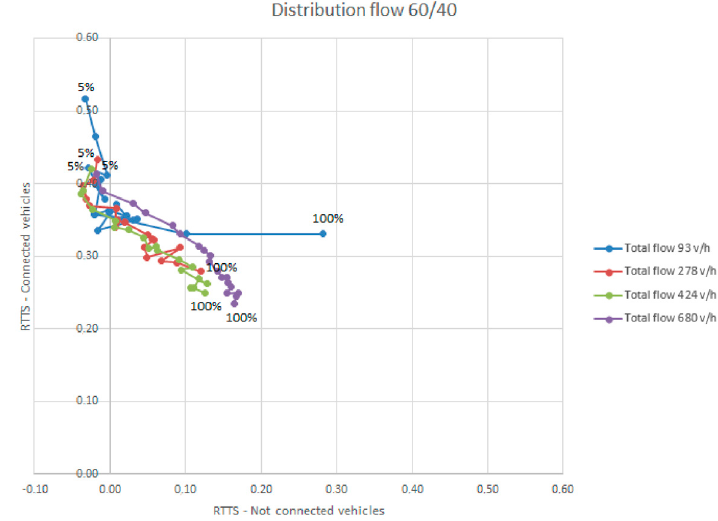
Figure 8. Ratio of Travel Time Saving for traffic light cycle A (Distribution of flow 60/40).